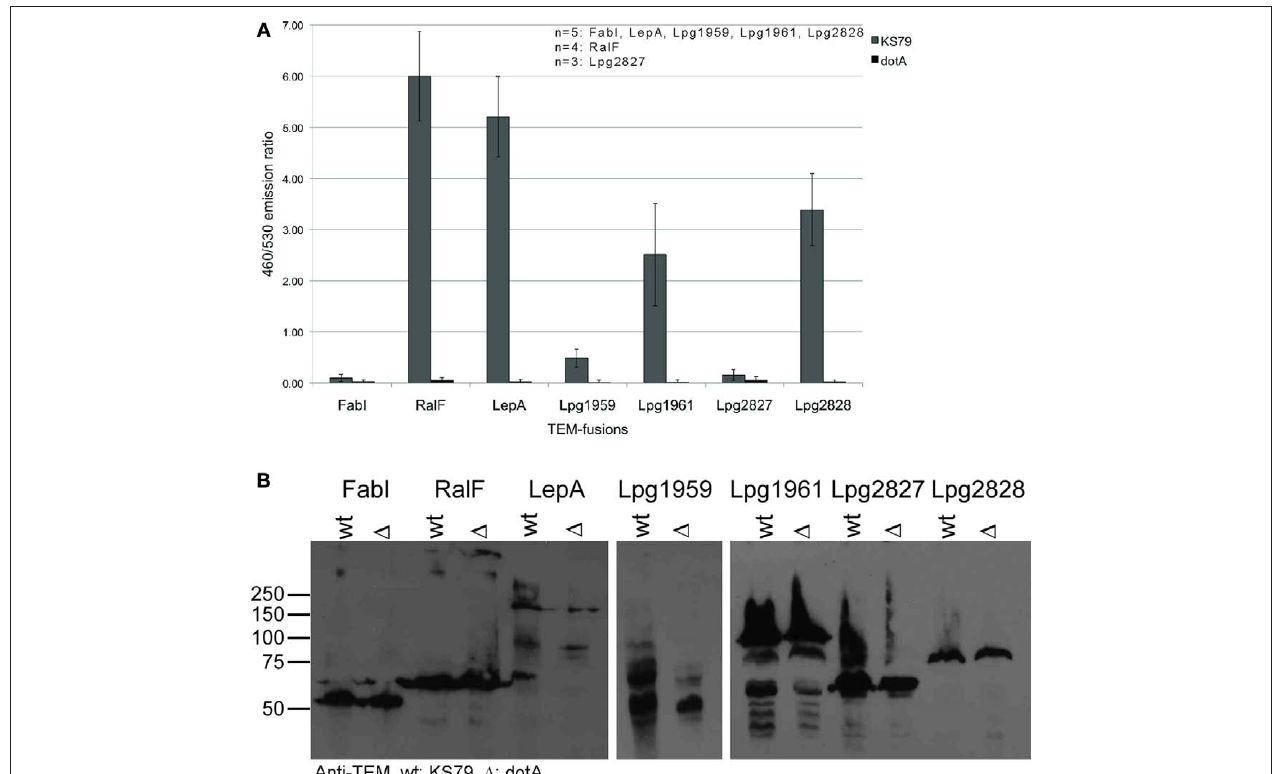
The number of biological replicates analyzed is shown. (B) Immunoblot on whole cell lysate using an anti-TEM rabbit polyclonal antibody showing expression of the TEM-effector fusions. Moleular weight of fusion proteins: TEM-FabI: 59.3 kDa, TEM-RalF: 73 kDa, TEM-LepA: 161.9 kDa,